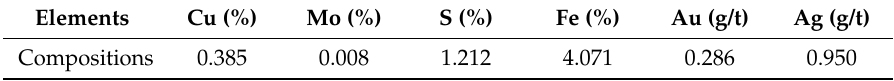
Table 1. Chemical analysis of the ore. All percentages are given as weight percentage of the total.